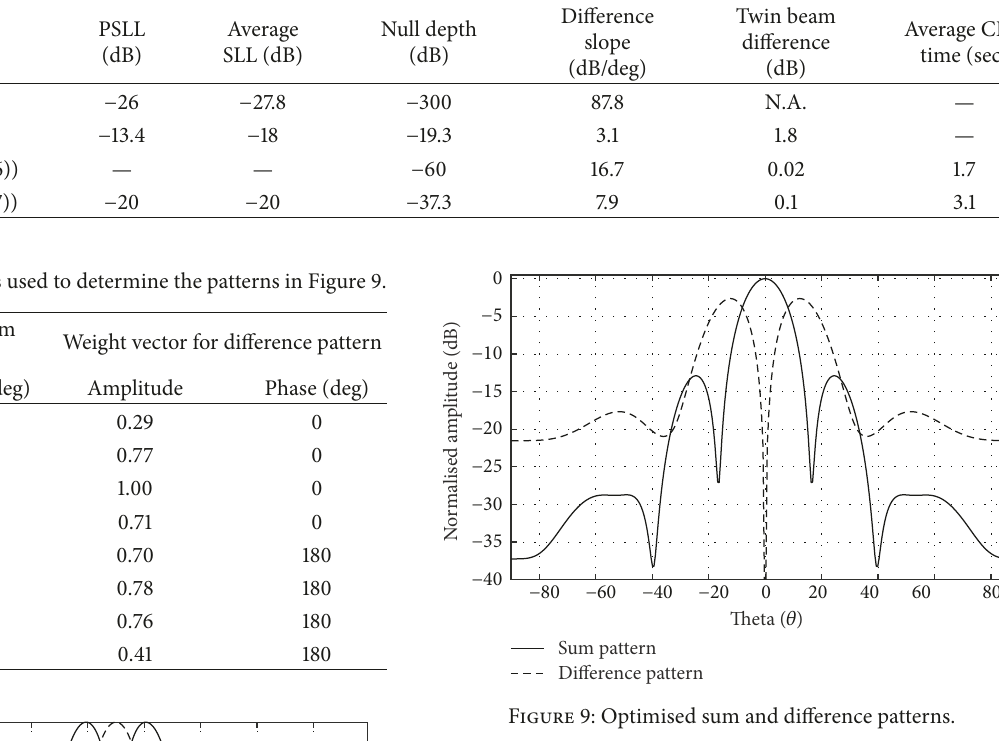
Table 1: Results summarized from Figures 4 and 6.